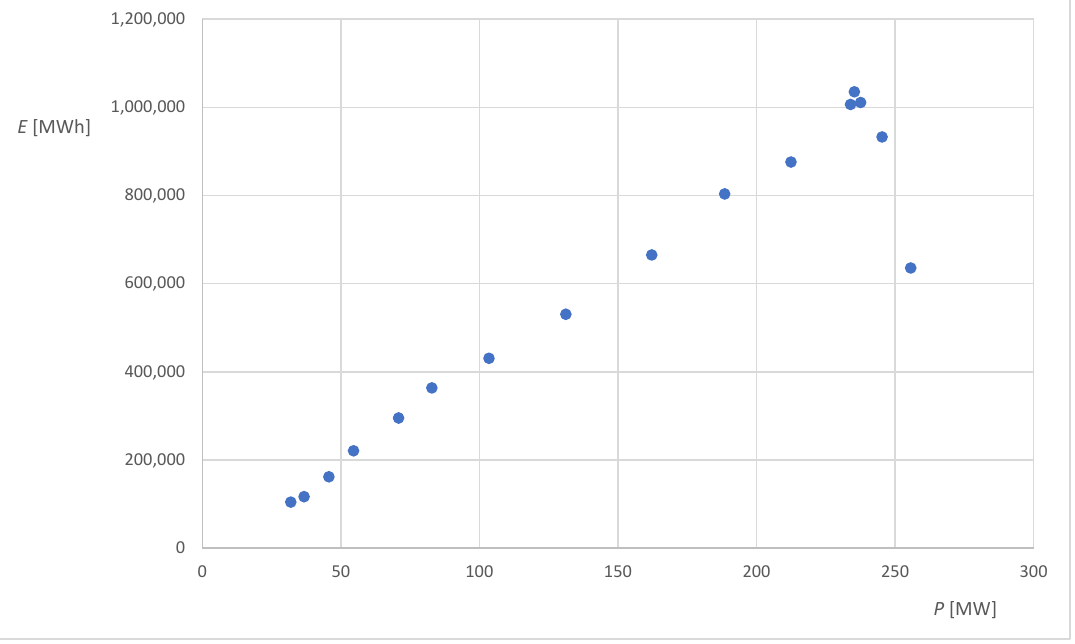
Figure 7. Relationship between biogas power installed in Poland and the amount of electricity generated from biogas in Poland (own elaboration). The lack of a well-oriented trend in the e ffi ciency of installations based on biomass processing is shown in Figure 8.